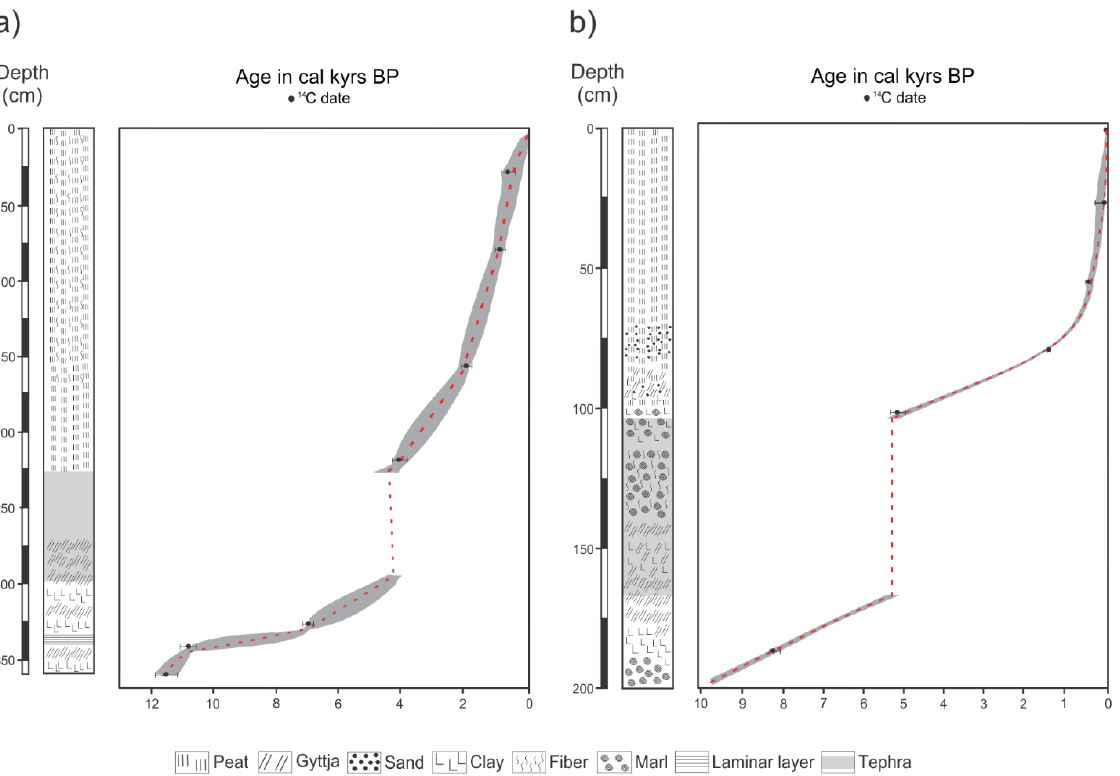
Figure 3. Sediment descriptions (modified from Sottile 2014 and Echeverria et al. 2014) and age-depth curves of the peat cores (a) Península Avellaneda Alto (PAA), and (b) Península Avellaneda Bajo